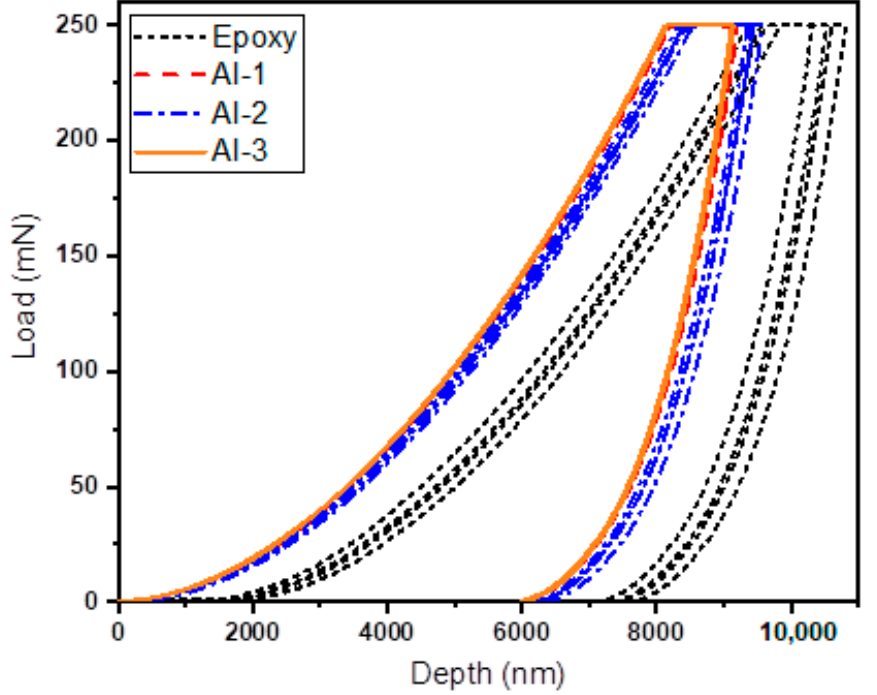
Figure 5. Obtained indentation curves for neat epoxy as well as with the Al particles in different percentages.